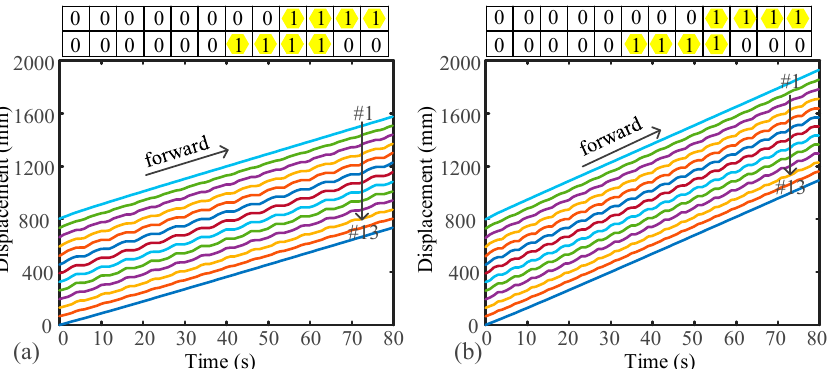
Figure 11. Locomotion simulations of a 12-segment earthworm-like robot based on U-DM with MG-Ⅱ . The line located in the number is the locomotion tracks of the body segments. The driven module consists of four actuated segments. ( a ) The transmission segments contain two segments. ( b ) The transmission segments contain three segments.